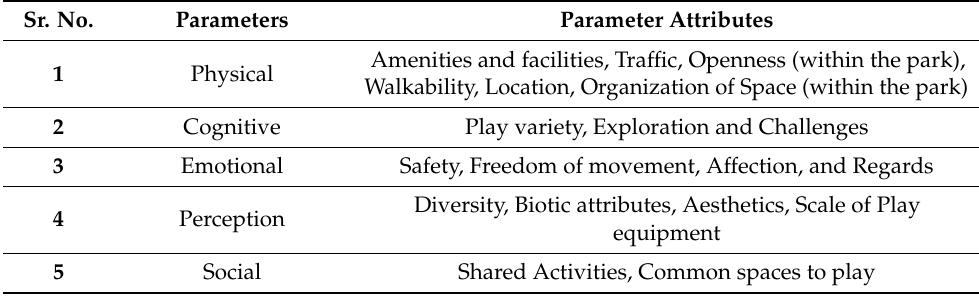
Table 10. Factors for Evaluating Child-Friendly